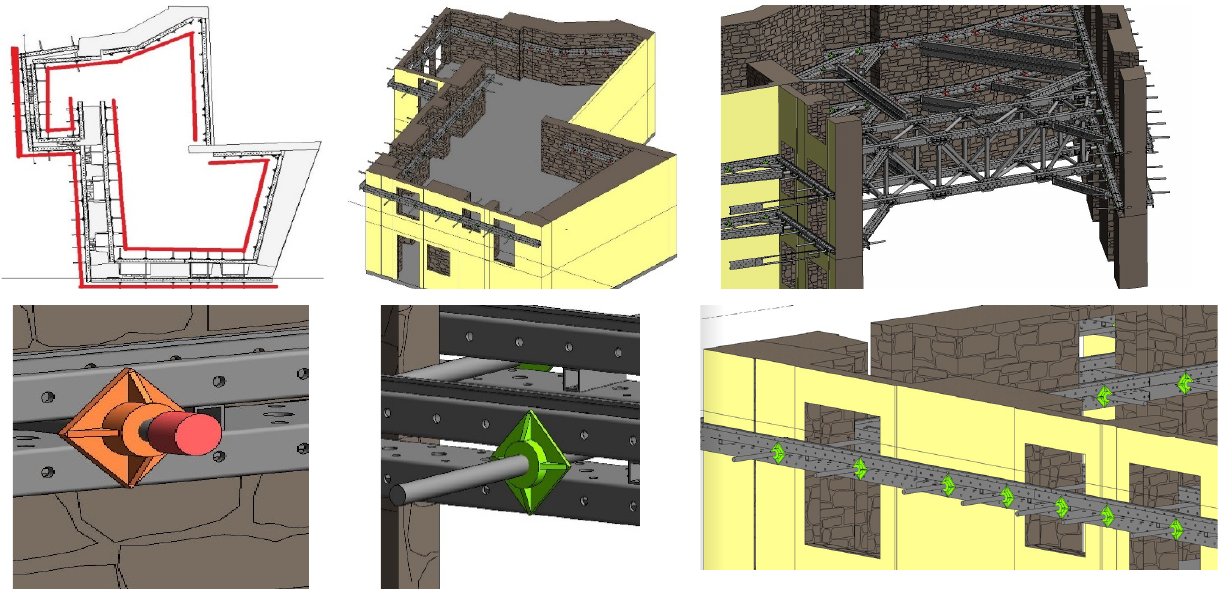
Figure 11. Plan showing the position of the temporary structural elements and details of the 3D model.